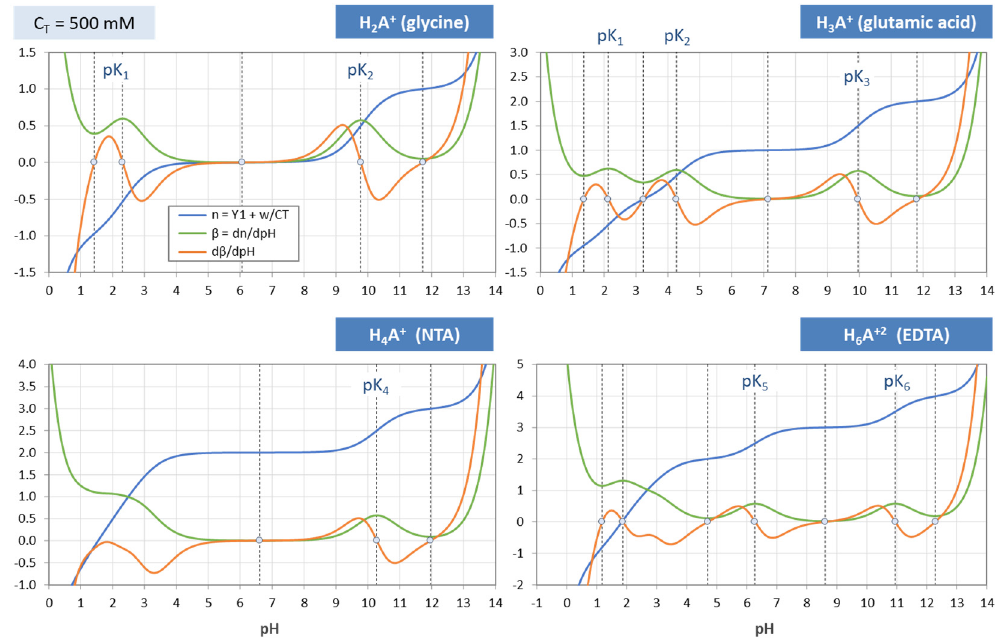
Figure 38. Same as Figure 37, but for C T = 500 mM.